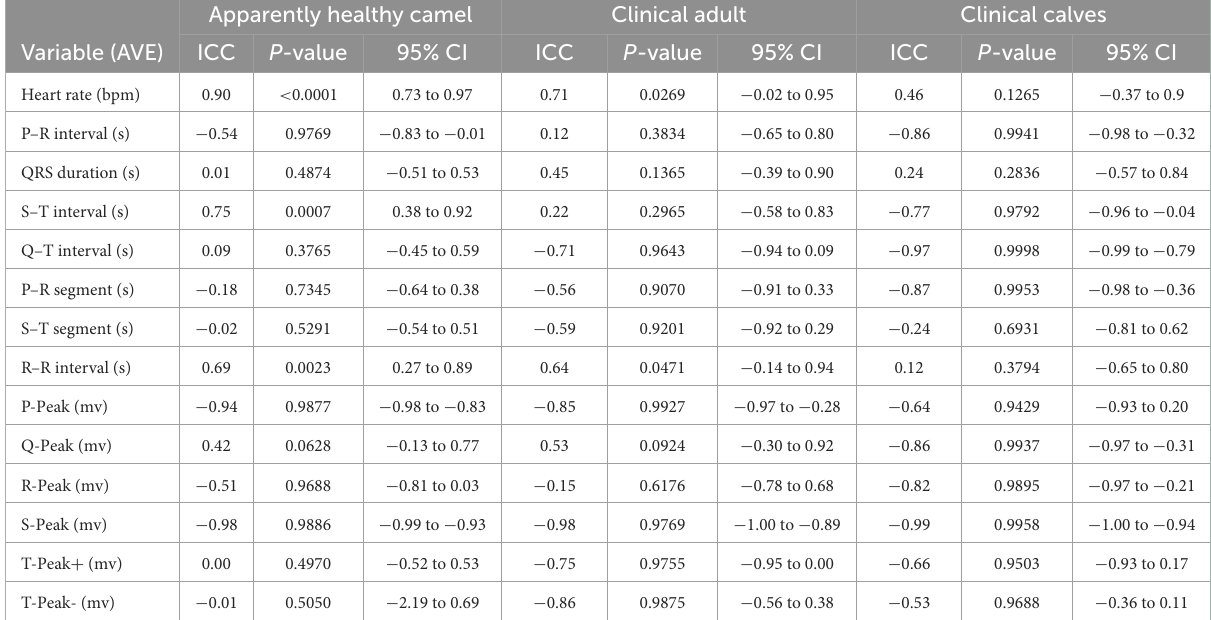
TABLE 3 Agreement between two methods of ECG trace for intraclass correlation coefficient (ICC) and average (AVE) over three examiners for each category. Apparently healthy camel Clinical adult Clinical